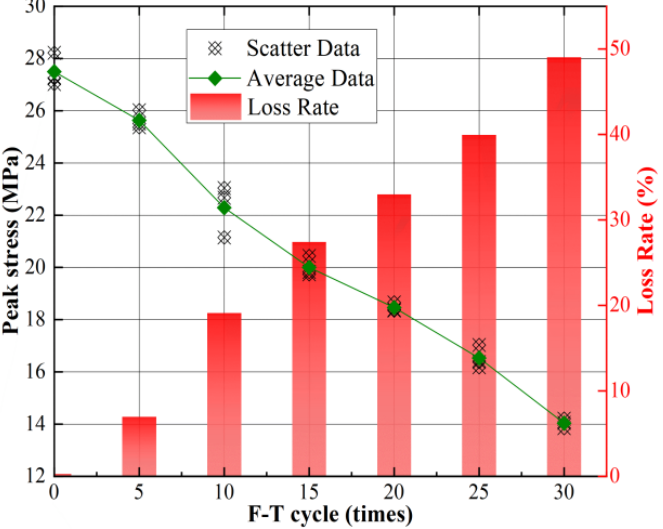
Figure 11. Change in the peak stress and loss rate with F-T action in the tested sandstone. As shown in Figure 12, a schematic diagram of the freezing sequence of the ‘main- side branch’ was developed based on the size of the pore structure. The F-T damage in sandstone is the result of a combination of capillary, crystal pressure, hydrostatic, and volumetric expansion mechanisms [13]. When the temperature drops below 0 ◦ C, the main pores initially freeze as ice by heterogeneous nucleation due to their greater curvature [27]. At this time, the ice in the pores drives the unfrozen water to form seepage damage on the pore wall, which is known as the hydrostatic pressure mechanism. The volumetric expansion mechanism, on the other hand, is the damage that is caused by the volumetric expansion of the ice [9]. Since the chemical potential of the water in the small pores is higher than that of the pore ice in the main pores, the supercooled water from the small pores migrates through the pellicular water into the main pores, promoting further development of the structural damage in the pores [27]. The capillary mechanism plays an important role in this process. In addition, when the pore ice develops into secondary pores, the growth of the pore ice causes a hydraulic fracturing effect at the pore tips when the secondary pores are closed [5]. As the F-T effect increases, the damage to the pore structure in the sandstone increases. Thus, as mentioned above, there are significant differences in the physical and mechanical behavior of sandstone under